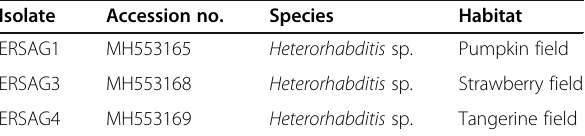
Table 1 Gene bank accession numbers for ITS1-5.8S-ITS2 sequences and the result of their BLAST against the Nucleotide collection (nt) database of the NCBI website Isolate Accession no.